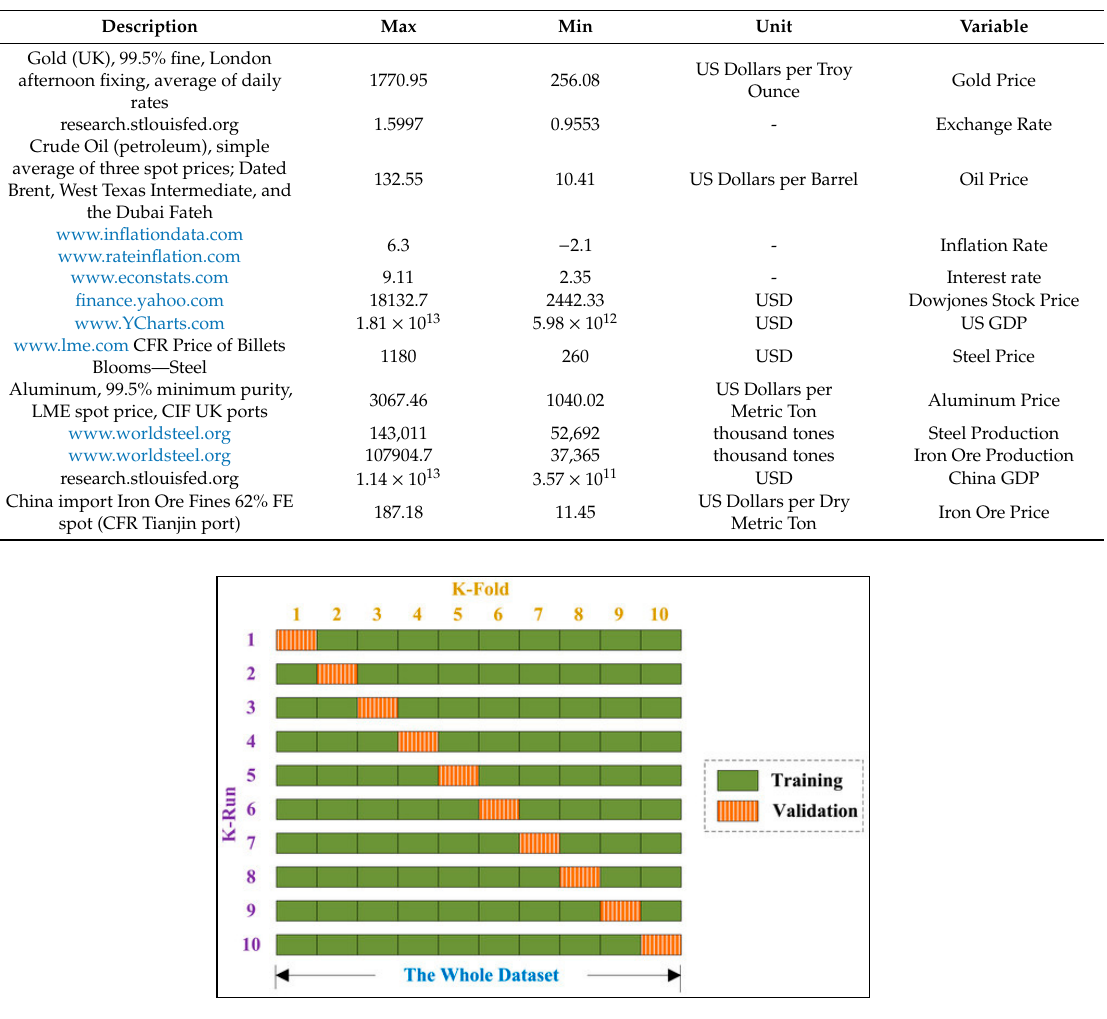
Figure 2. Ten-fold cross-validation.